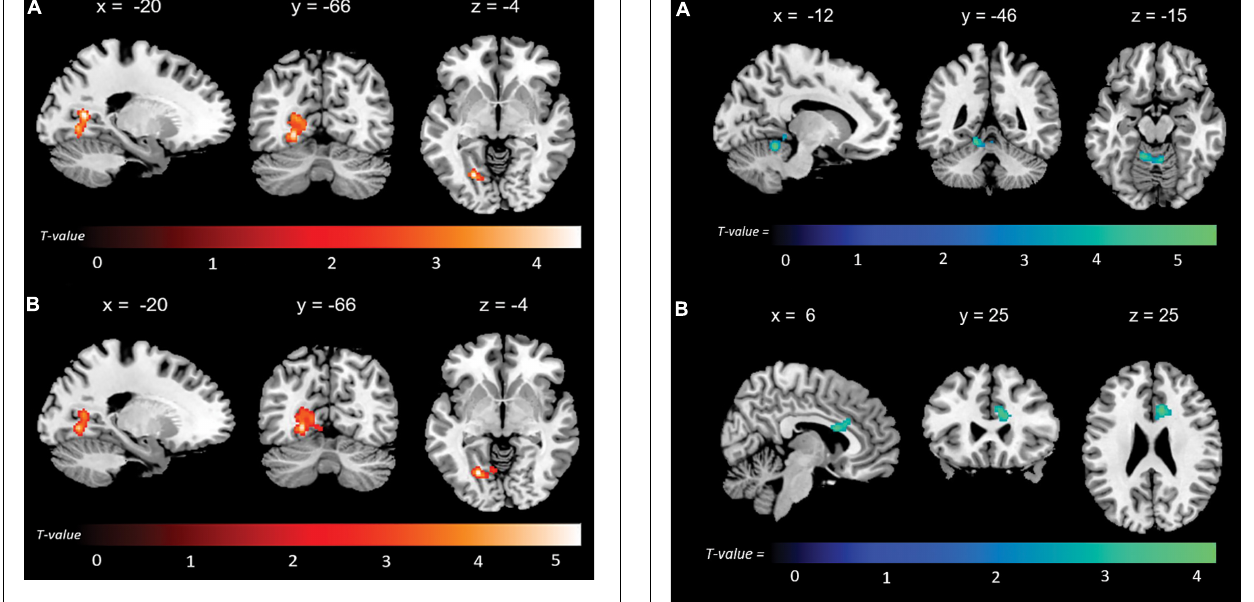
Non-memory anosognosia scores were negatively associated with: right lingual connectivity in the right dorsolateral prefrontal cortex ( k = 590, p = 0.002); right precuneal connectivity in the right transverse temporal gyrus (BA 41) and in a caudate-thalamic area ( k = 802, p = 0.001). Non-memory anosognosia scores were positively associated with: left anterior- cingulate connectivity in the right dorsolateral prefrontal cortex ( k = 434, p = 0.012); left medioprefrontal connectivity in the right dorsolateral prefrontal cortex ( k = 318, p = 0.048); and left hippocampal connectivity in a left caudate-insular cluster ( k = 354, p = 0.031). All these findings are shown in Table 4 and Figure 5 .